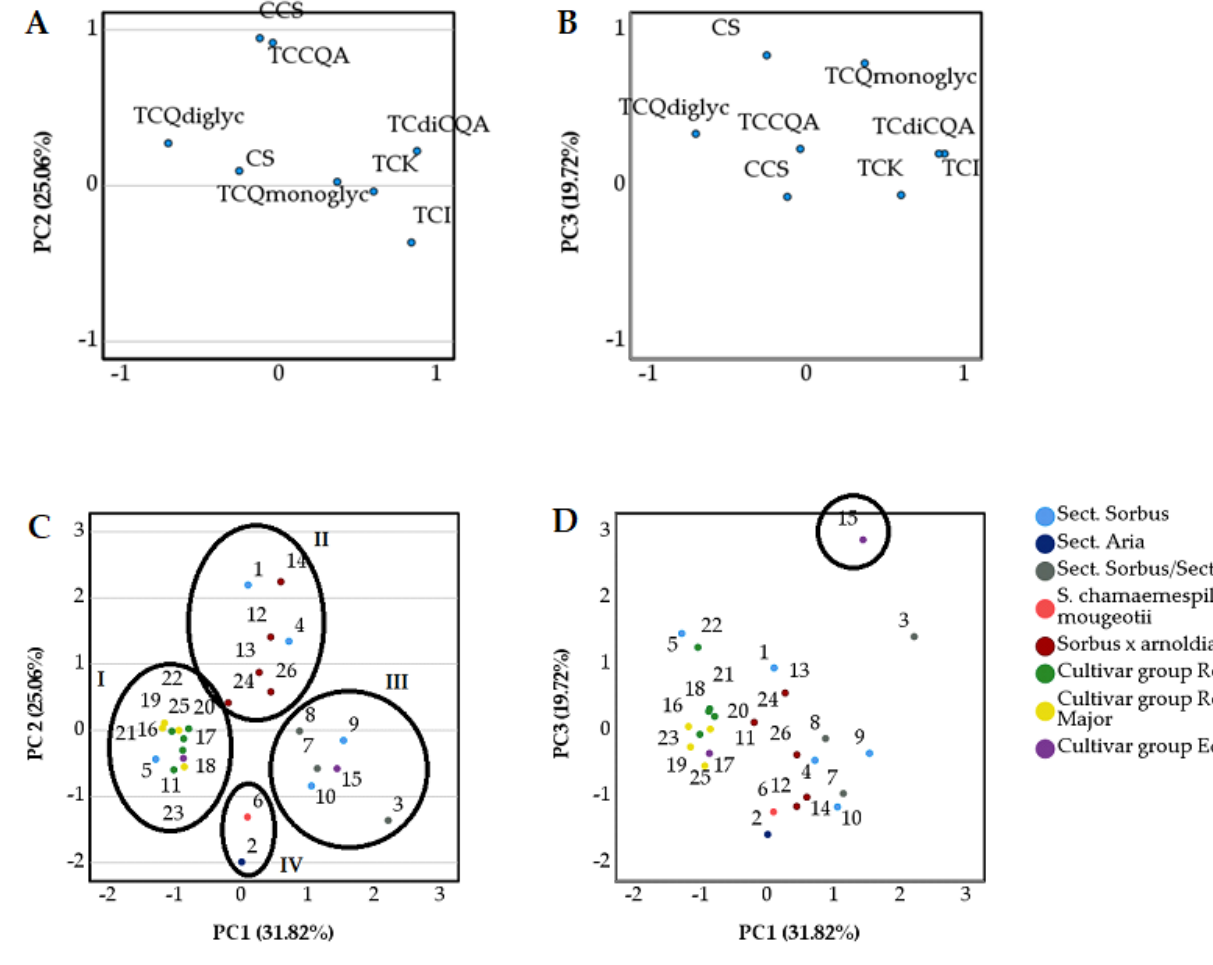
Figure 2. PCA loading plots ( A , B ) and score plots ( C , D ) for different Sorbus inflorescence samples.